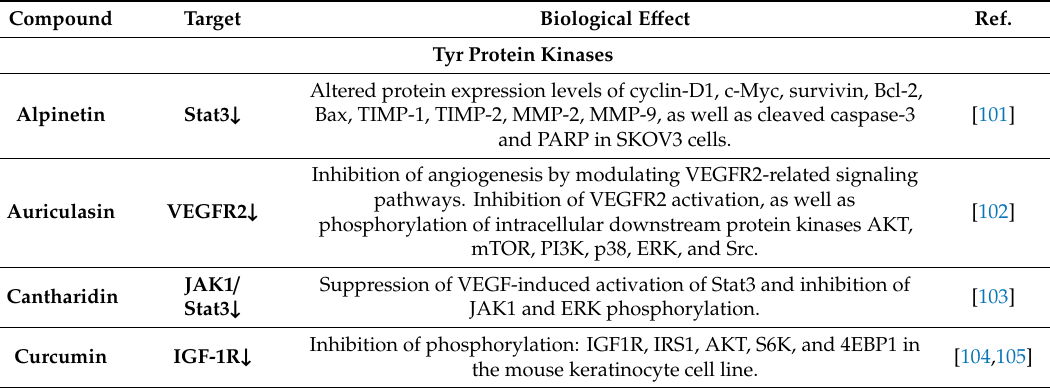
Table 2. Examples of natural products a ff ecting protein kinase